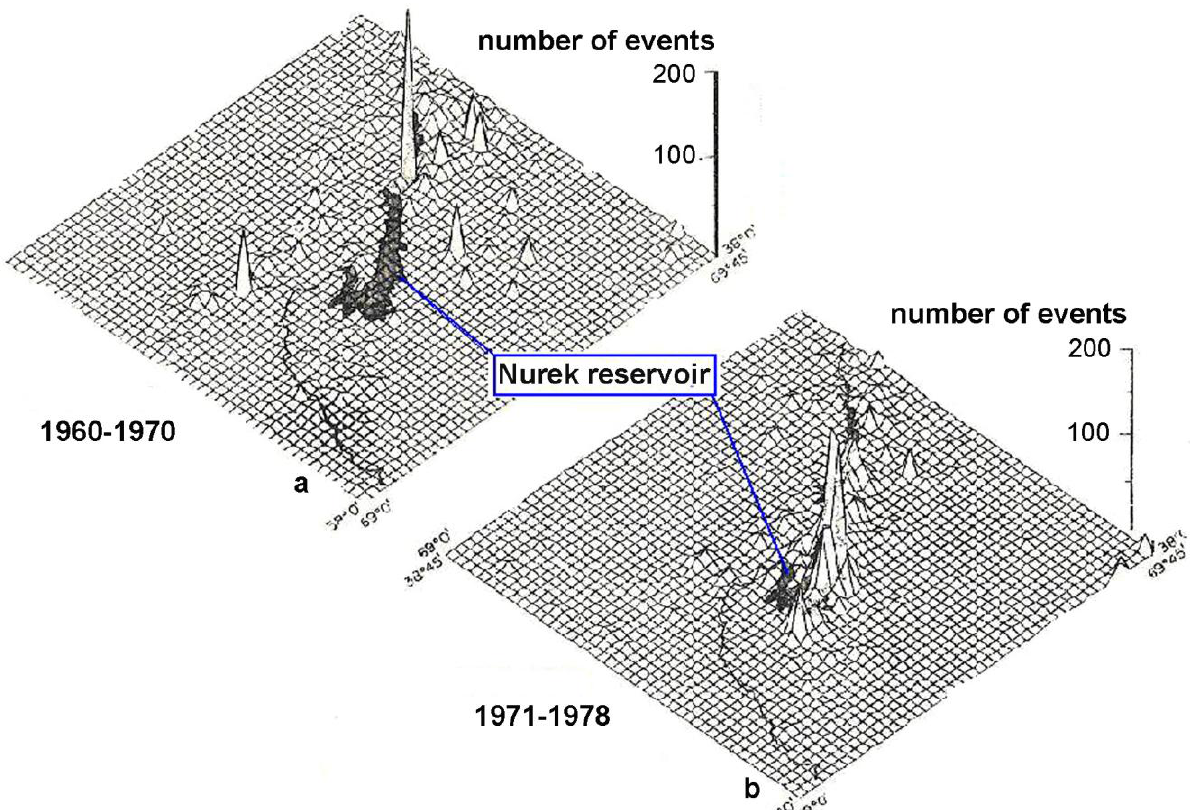
Fig. 2. Three-dimensional view of Nurek reservoir seismicity area: a) before filling (1960-1970) and b) after filling (1971- 1978). Vertical axis shows the number of earthquakes K ≥6.5 (based on Mirzoyev et al.,